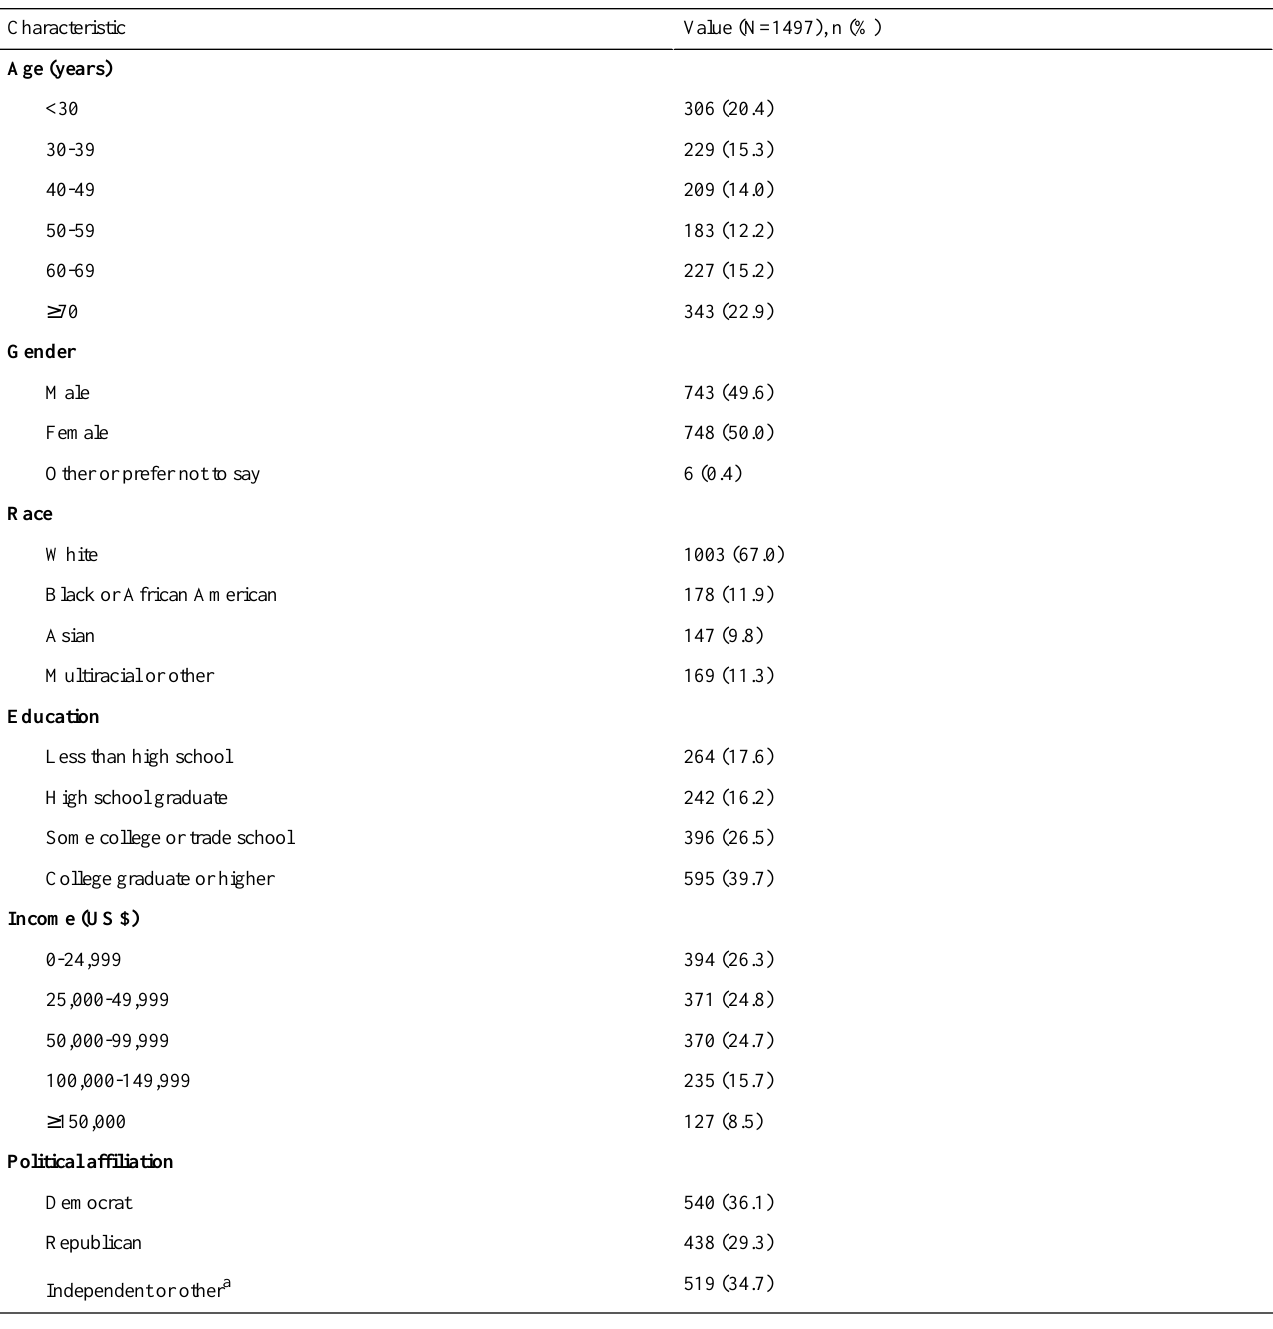
Table 1. Sample population